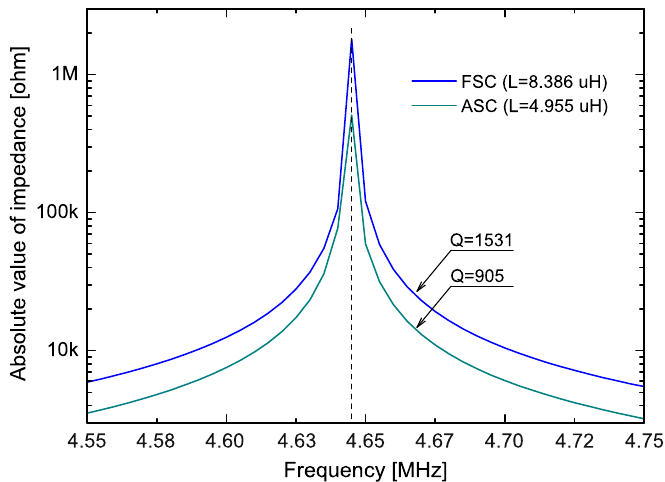
Figure 7. Simulating the frequency dependences of the lumped-port impedance in the frequency range 4.55–4.75 MHz.